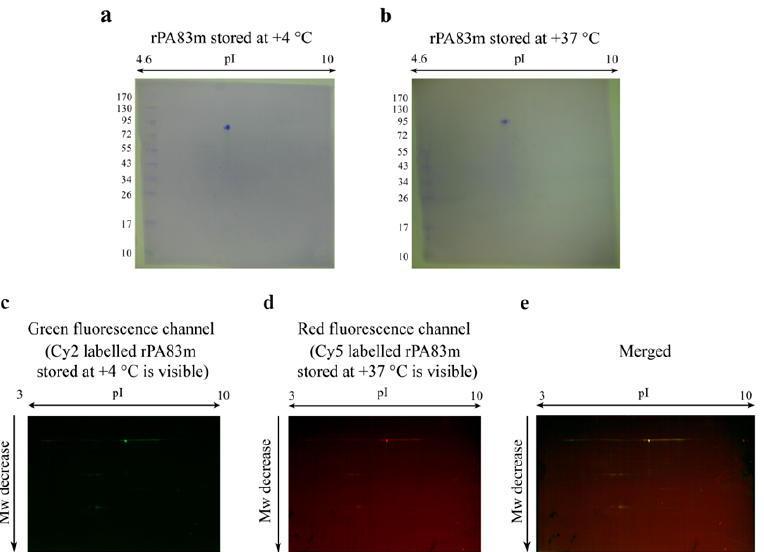
Figure A2. 2D-electrophoresis analysis of rPA83m stored at +4 °C or at +37 °C. ( a , b ) 2D-electrophoresis of rPA83m samples stored for 7 days at +4 ° С ( a ) or +37 ° С ( b ). 10 µg of rPA83m was loaded on each gel. Protein molecular mass ladder (10–170 kDa) (Fermentas, Thermo Fisher Scientific, Waltham, MA, USA) was added during the stage of separation of molecular weight. Coomassie G-250 blue staining. ( c – e ) Simultaneous analysis of rPA83m samples stored for 5 days at +4 ° С or +37 ° С . After storage rPA83m samples incubated at +4 ° С or at +37 ° С were labelled with Cyanine2 (green) or Cyanine5 (red) fluorophore, respectively. 3 µg of each sample was simulta- neously loaded on the gel. Images of gel scanning in green ( c ) and red ( d ) fluorescence channel as well as merged image ( e ) are represented. Appendix C In this case, rPA was described to be subjected to thermally-induced aggregation that leads to the formation of large aggregates which could be visually detected [26–28] and precipitated from the solution during centrifugation [29]. The aggregation state of stored rPA83m was checked (Figure A3). No visual differences between solutions of rPA83m stored at +4 °C, +25 °C or +37 °C were detected neither after 7 days (Figure A3a), nor after 20 days (Figure A3b). Moreover, SDS–PAGE analysis revealed the equality of rPA83m amount in the supernatant of the stored samples after centrifugation (20 min; 16,100× g ) and in non-centrifuged stored samples (Figure A3c,d). This fact indicates the lack of large aggregates in rPA83m solution even after 20 days storage at +37 °C.